Question: What kind of plot is shown here?
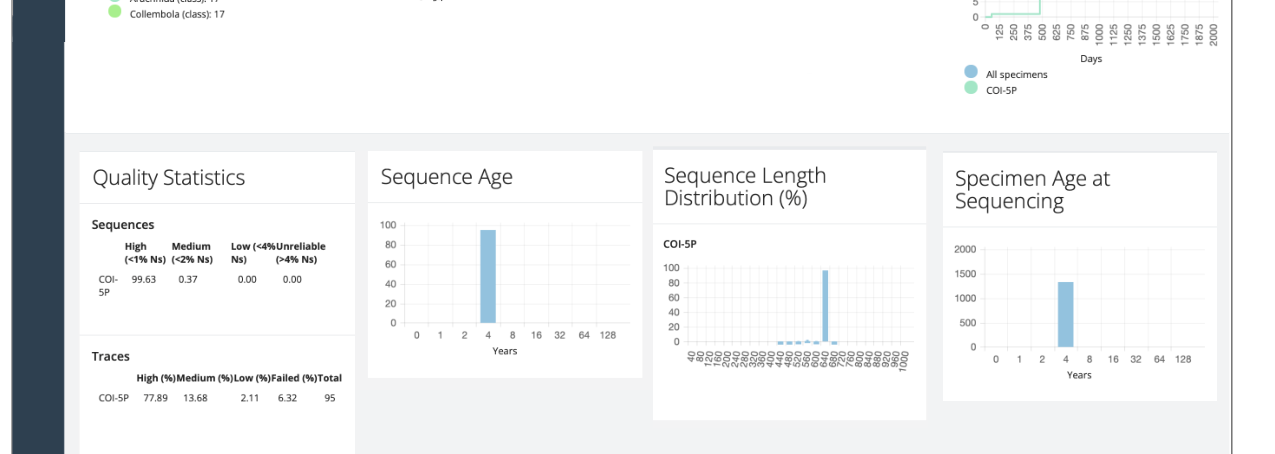
Answer: histogram